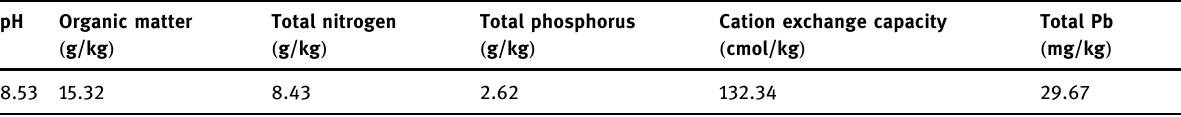
Table 1: Physical and chemical properties of the original soil pH Organic matter ( g/kg )